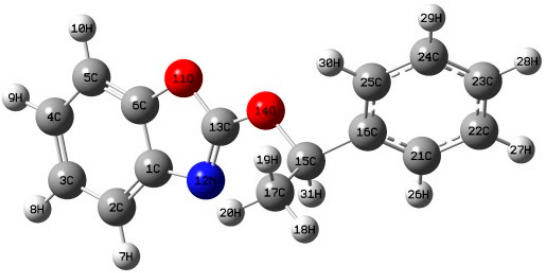
Figure 5. Int3 species with higher electrophilicity of the nitrogen atom center.